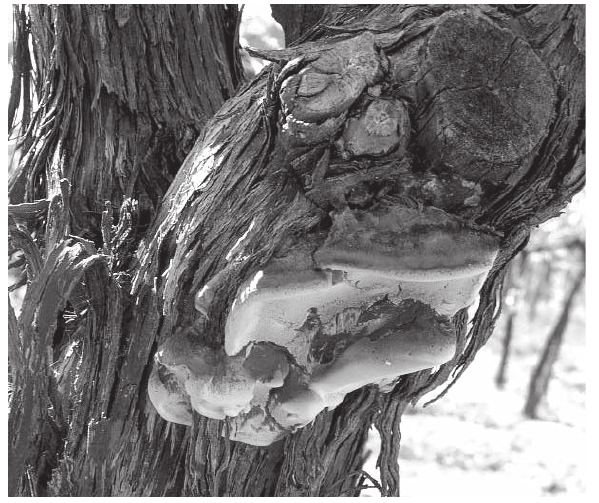
Fig. 1. Basidiocarps of Inocutis jamaicensis on the trunk of a diseased